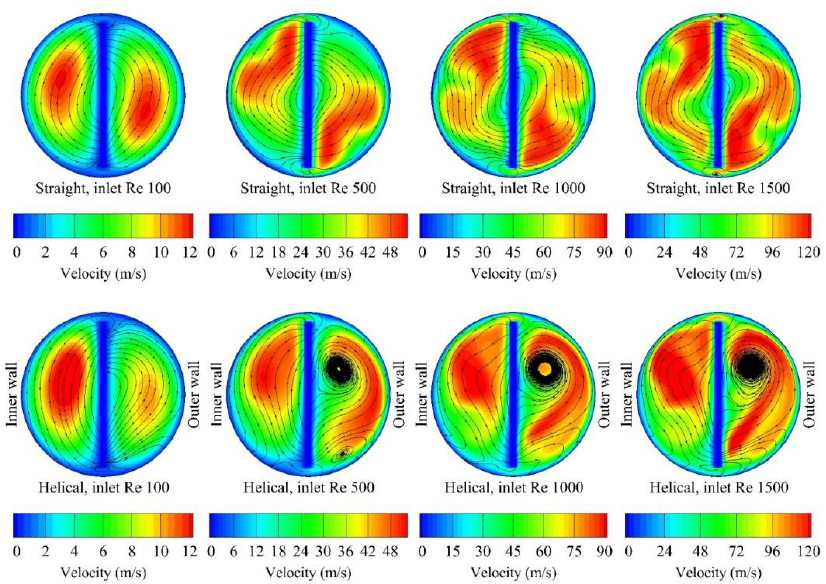
Figure 5. Velocity profile (contour, m/s) and streamlines of reactant flow in straight and helical reactors with insert tape twisting ratio of 3.15 at L = 25.16 mm different inlet Reynolds numbers.